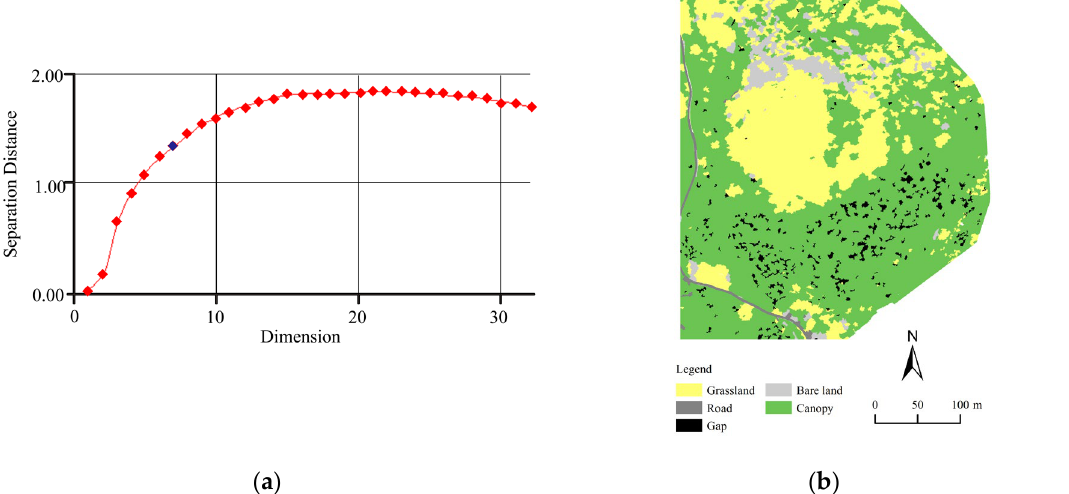
Figure 6. The canopy information extraction from Shenxiantang tiankeng based on optimal feature combination. ( a ) The relationship between the number of features and the separation distance of Shenxiantang tiankeng. The small blue square is the number of features. ( b ) Results of canopy information extraction for Shenxiantang tiankeng.